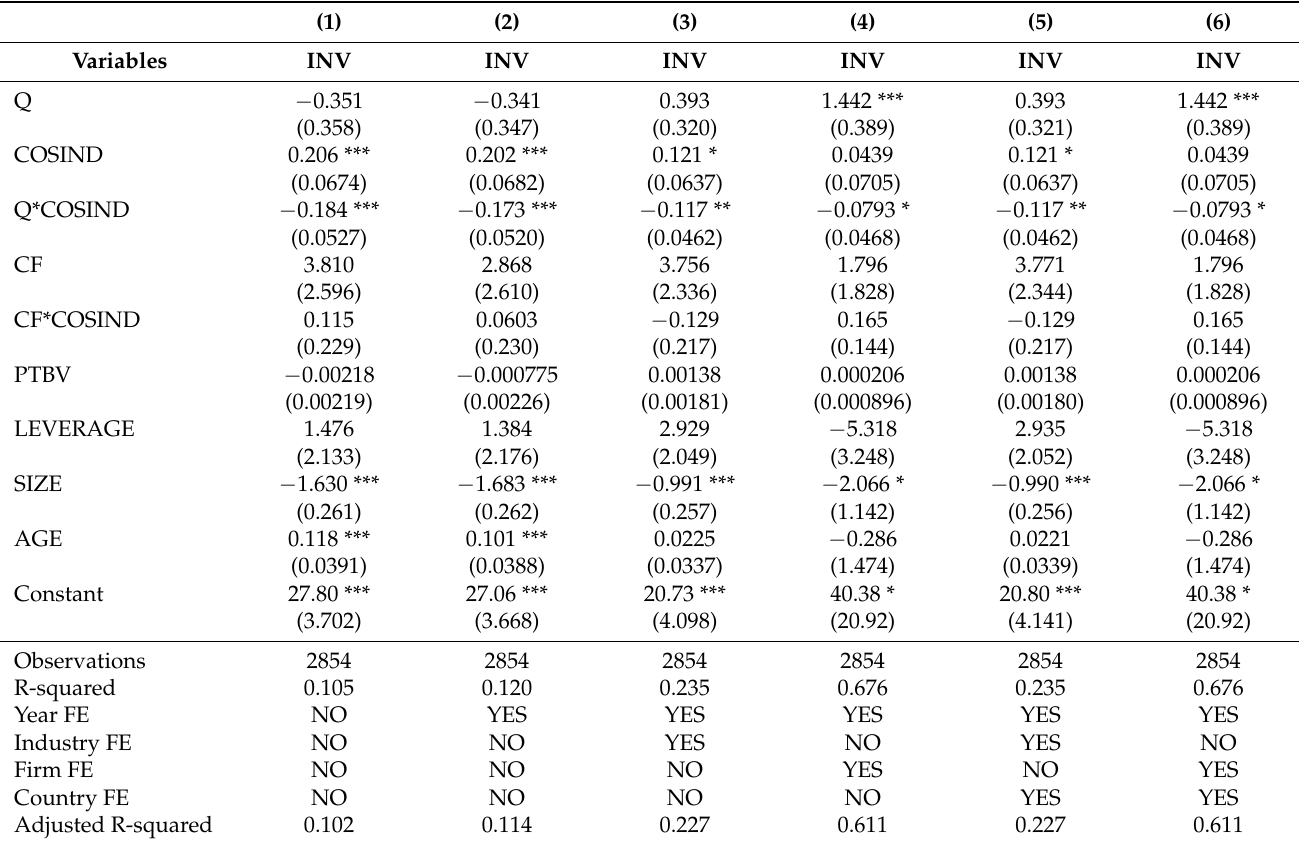
Table 5. The costly CSR initiatives and investment efficiency.